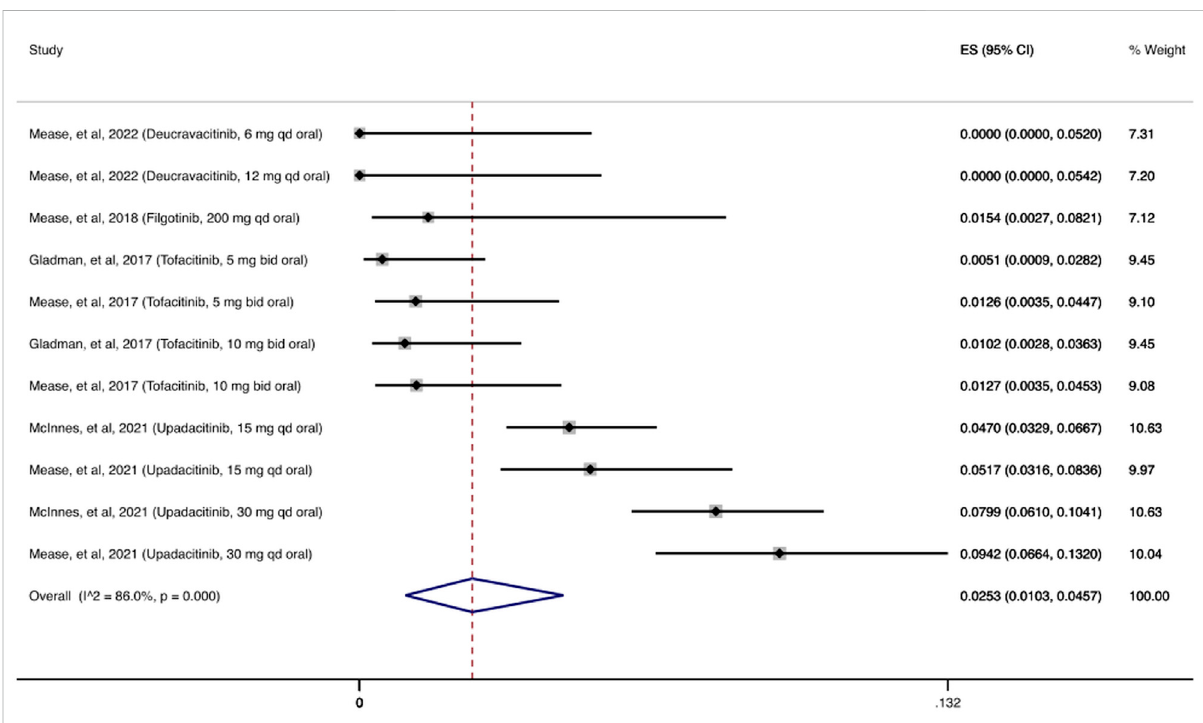
FIGURE 5 Herpes zoster infection cumulative incidence for JAK inhibitors during RCTs and their extension periods. Individual and combined estimates of theincidenceofherpeszosterinfectionforpatientstreatedwithJAKinhibitorswith95%cumulativecon fi denceintervals.ES:EffectSize(Cumulative